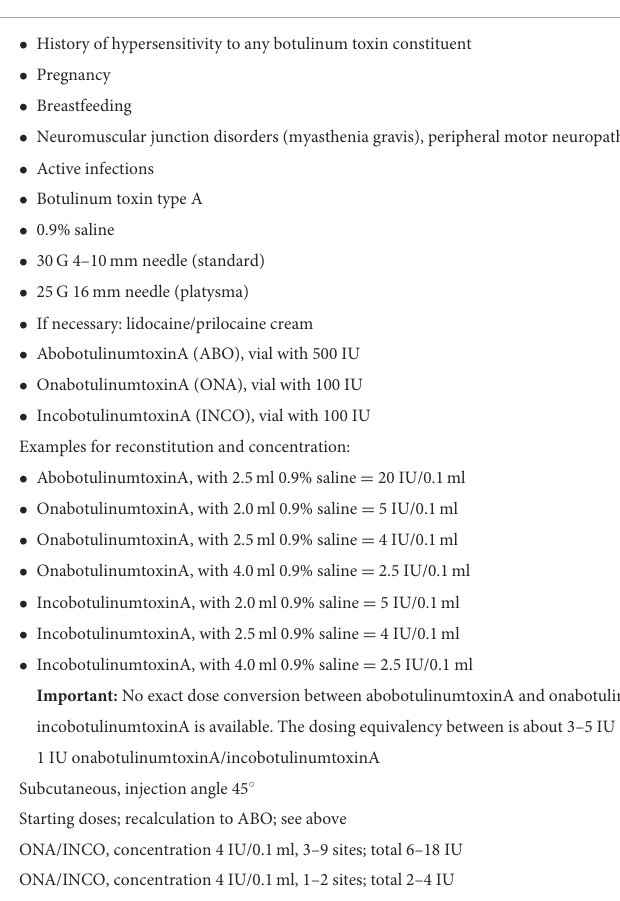
TABLE 6 Hints and typical dosages for botulinum toxin type A application for facial synkinesis.